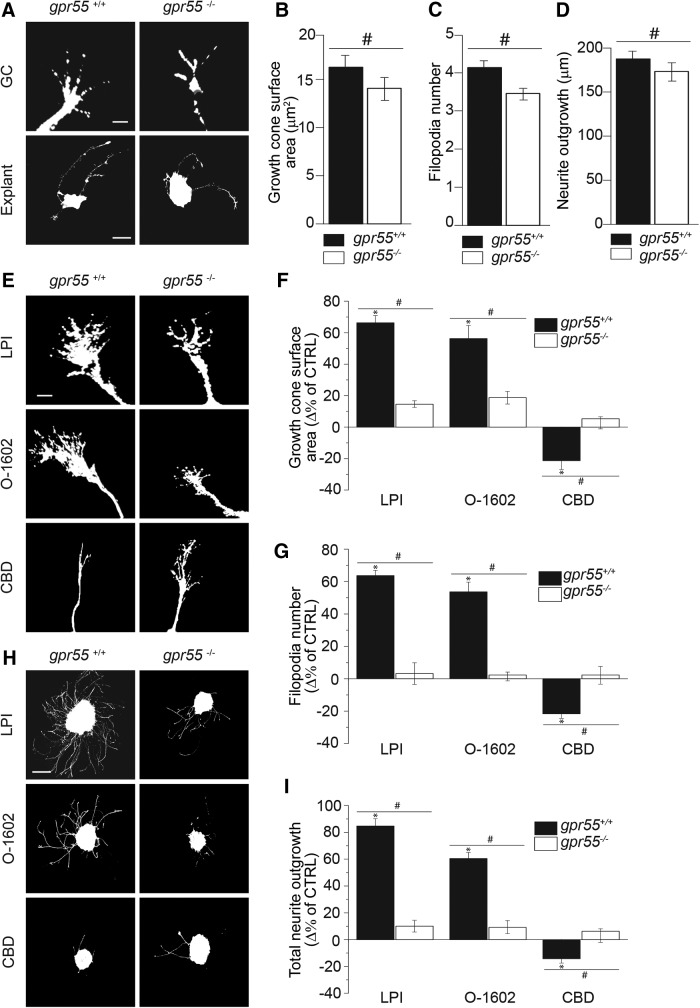
GPR55 mediates the reorganization of the GC morphology and the modulation of axon growth. A–D, Basal growth cone surface area, filopodia number and total neurite outgrowth in gpr55+/+ and gpr55-/- retinal explants. E–G, Growth cone surface area and filopodia number in gpr55+/+ and gpr55-/- retinal explants treated for 1 h with LPI (1 µm), O-1602 (300 nm), or CBD (300 nm). H, I, Total neurite outgrowth in gpr55+/+ and gpr55-/- retinal explant treated for 15 h with LPI, O-1602, or CBD at the same previously cited concentrations. Scale bars: A, E, 5μm for GC; A, H, 100 μm for explants. Values are presented as mean ± SEM. *Indicates a significant change induced by LPI, O-1602, or CBD compared with the control in F, G, and I; p < 0.0001; #Indicates a significant change between LPI, O-1602, or CBD and the control in gpr55+/+ compared to gpr55-/- in F, G, I, and B–D; p < 0.004.